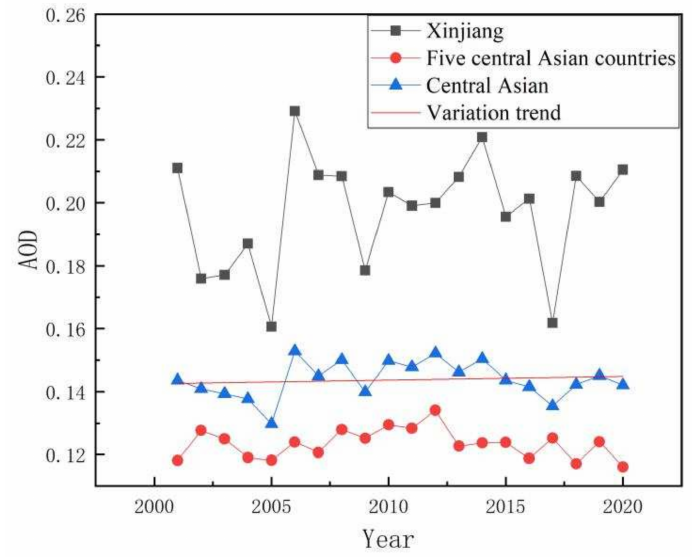
Figure 8. Trends in the AOD across Central